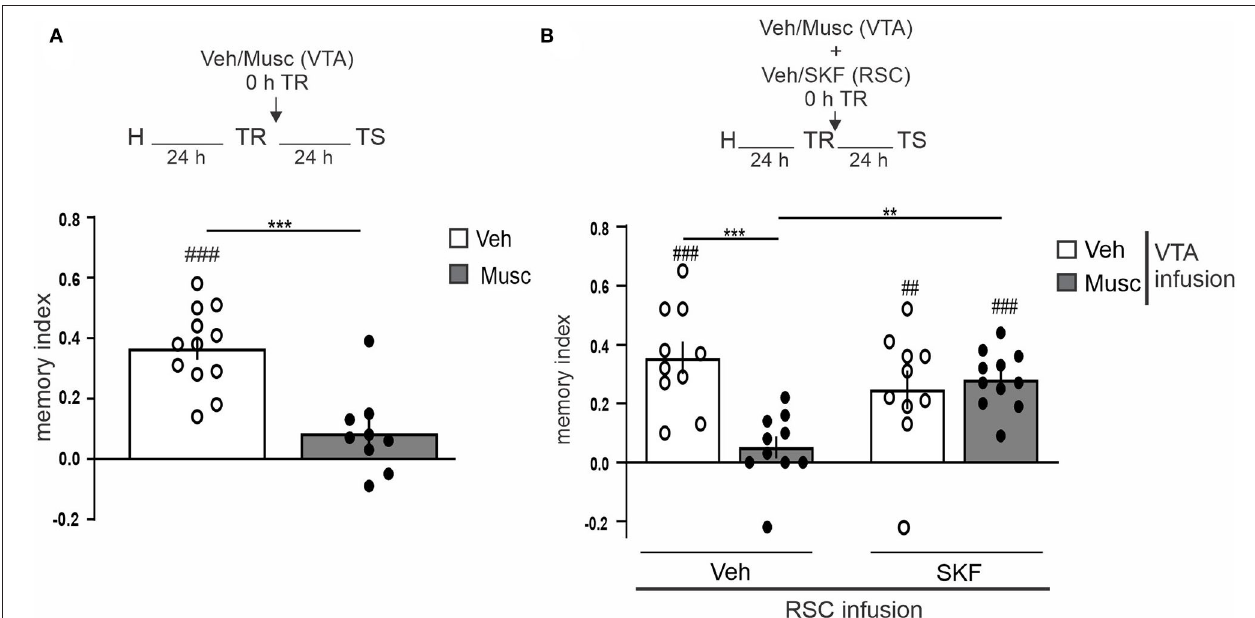
FIGURE 3 | VTA dopaminergic input to aRSC is required for object recognition memory consolidation. (A) Saline (Vehicle, Veh, white bar) or GABA A agonist (Muscimol, Musc, gray bar) infusions were made into VTA immediately after the training session; animals were tested 24h after the training. (B) simultaneously, saline (Vehicle, Veh, white bar) or GABA A agonist (Muscimol, Musc, gray bar) was infused into VTA and 10% DMSO (Vehicle, Veh) or D1/D5 agonist (SKF38393, SKF) was infused into aRSC immediately after the training. Test session was performed 24h after training. Data are expressed as mean discrimination index ± SEM. (A) *** p < 0.001, Veh vs. Musc, two-tailed Student’s t -test. (B) *** p < 0.001, ** p < 0.01, Tukey’s multiple comparison test after two-way ANOVA (only biologically relevant comparisons are shown). (A,B) ### p < 0.001, ## p < 0.01, Group vs. 0, two-tailed Student’s t -test. (A) n = 9–12, (B) n = 10–11. inactivation ( Figure 3B , p interaction = 0.0012, F interaction =